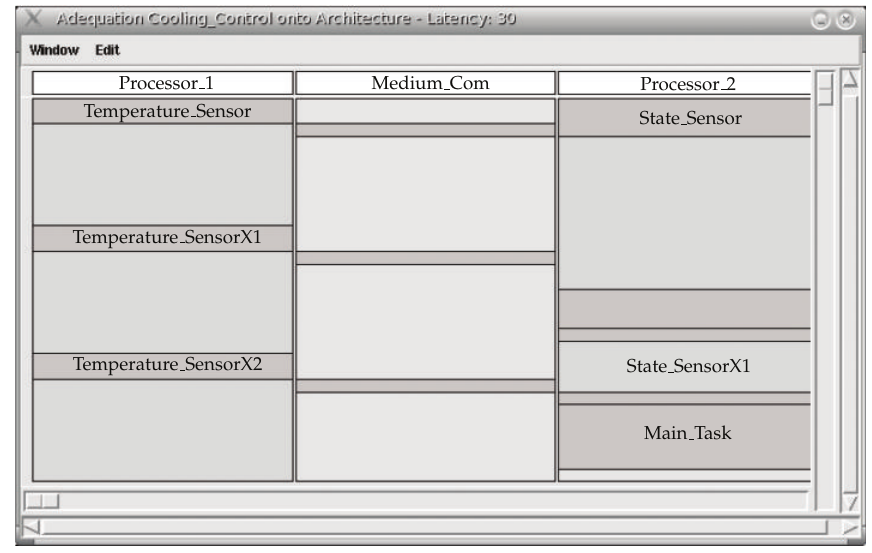
Figure 8: Cooling control (cid:3) distribution and scheduling (cid:4)